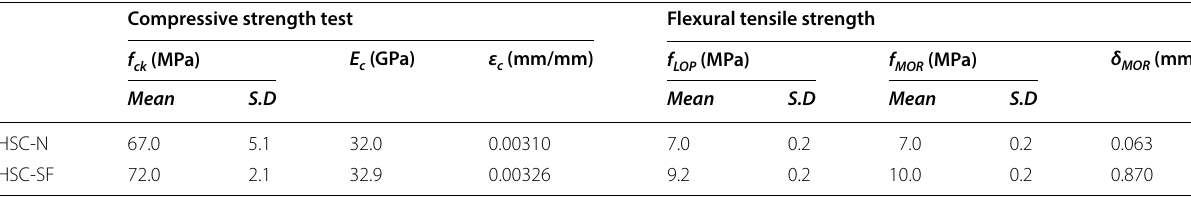
Table 7 Mechanical properties of